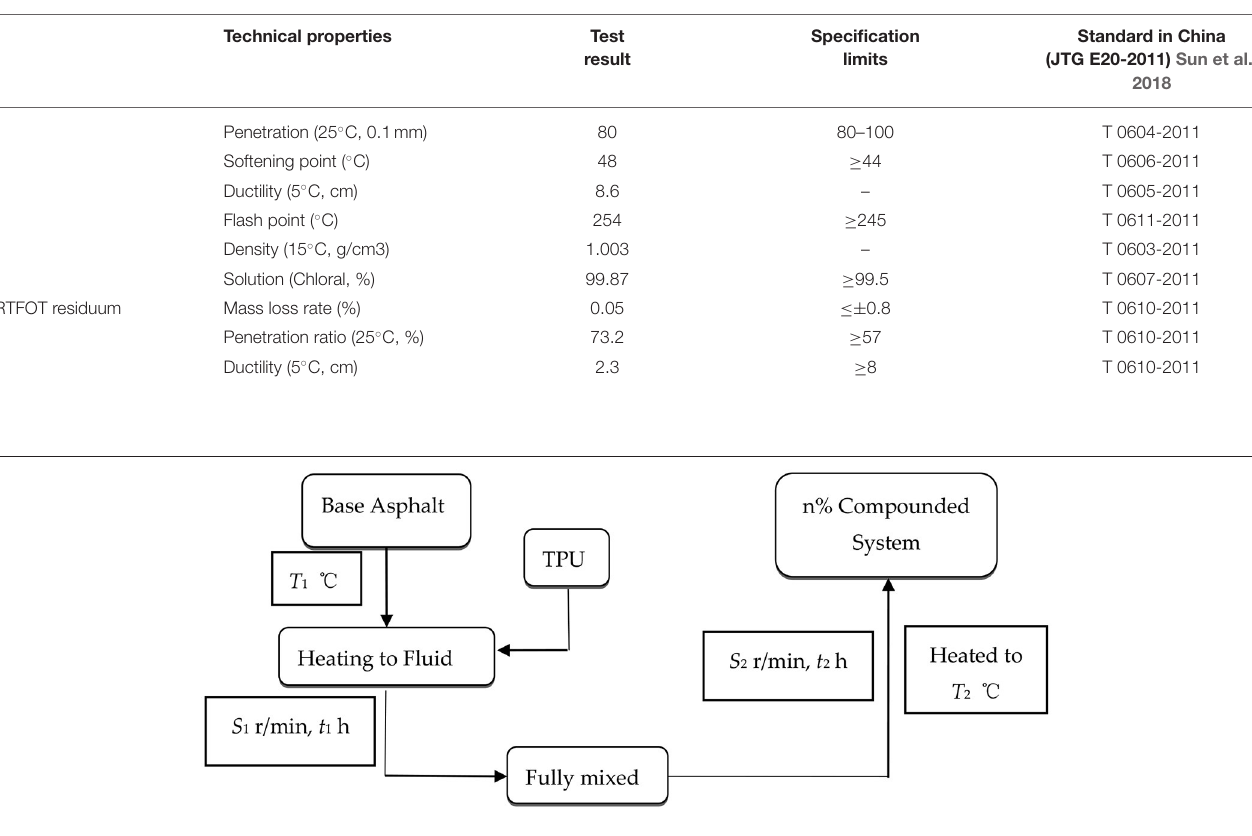
FIGURE 2 | Flowchart of preparation of TPU modified asphalt.